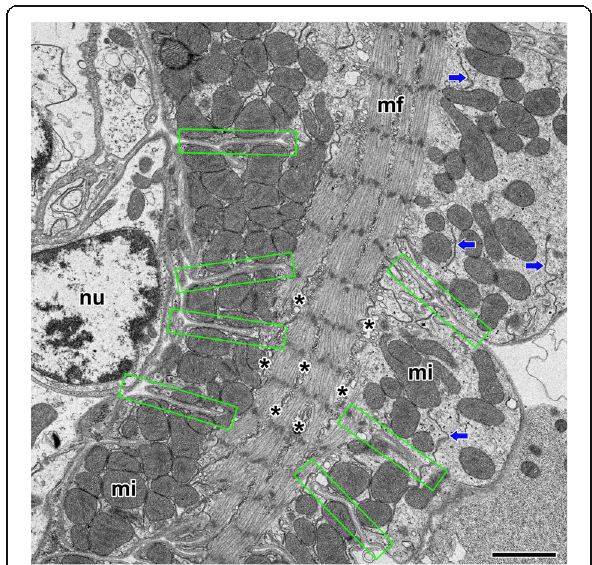
Fig. 2 Electron micrograph of the cardiac muscle cells surrounded by scalloped edge of the sarcolemma (rectangles) in the orb-web spider, N. clavata . Each fiber contains multiple myofibrils (mf) and numerous mitochondria (mi), extensive sarcoplasmic reticulum (asterisks) and T-tubules (arrows). Note deeply penetrated plasma membrane (pm), and highly aggregated mitochondria. nu: nucleus. Scale bar indicates 2 μ